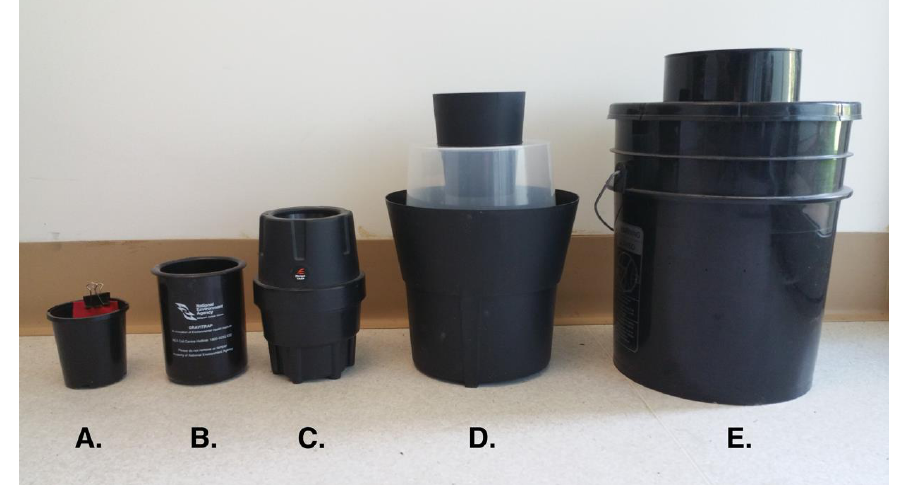
Figure 1. Common ovitraps used in recent mass-trapping campaigns: ( A ) standard (500 mL) lethal ovitrap (LO); ( B ) National Environmental Agency Singapore sticky ovitrap (SO); ( C ) MosquiTRAP sticky ovitrap (SO); ( D ) Biogents Gravid Aedes Trap (GAT); and ( E ) Centers for Disease Control (CDC) Autocidal Gravid Ovitrap (AGO).